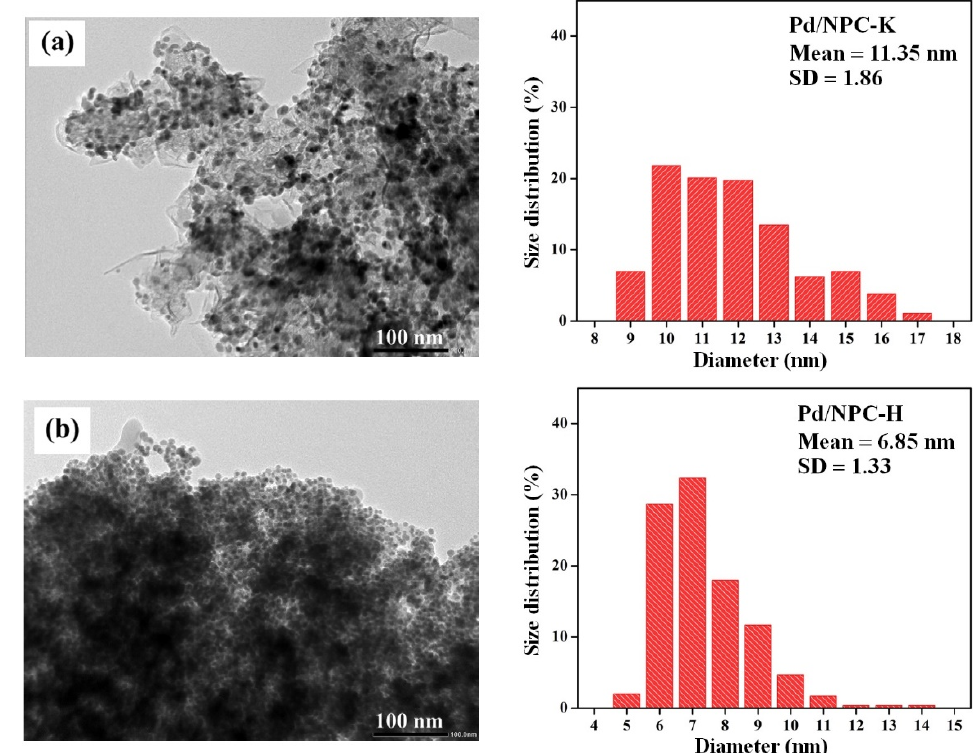
Figure 7. TEM micrographs and Pd size distribution of the ( a ) Pd/NPC-K and ( b ) Pd/NPC-H catalysts.